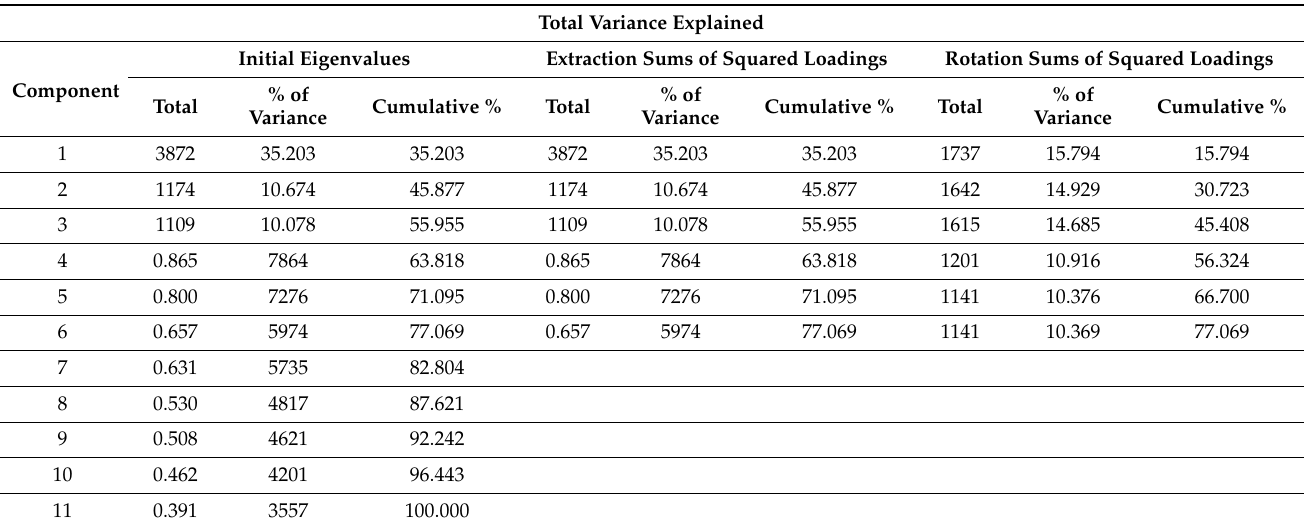
Table 3. The extracted factors together with their eigenvalues, percentage of variance, and cumulative percentage.